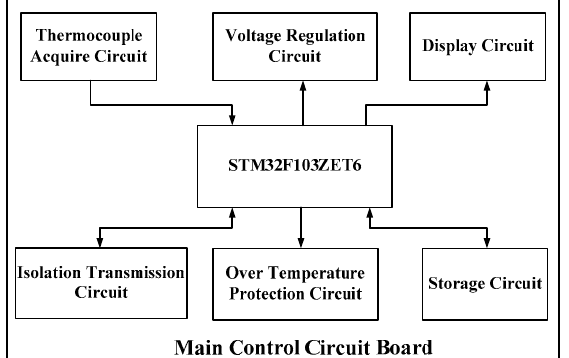
Figure 4. The structure diagram of main control circuit board.